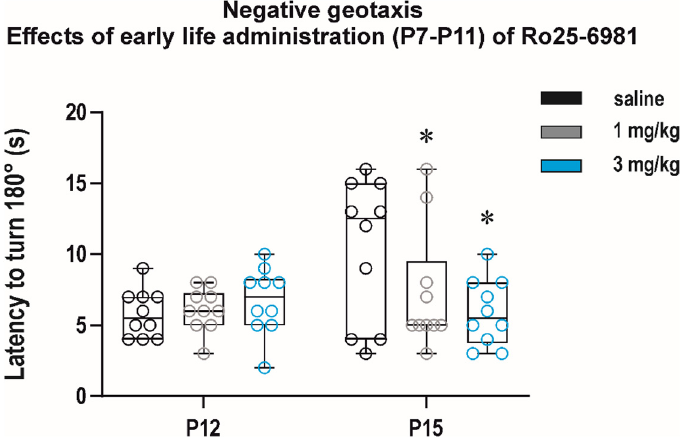
Figure 9. Effects of early life exposure to Ro25-6981 on performance in the negative geotaxis test. Ro25-6981 in two doses, 1 and 3 mg/kg, was administered intraperitoneally for five consecutive days, starting at P7 till P11. Each group consisted of 10 animals, and animals were tested after treatment cessation at P12 and P15 ( x axis). In the 2nd test at P15, animals exposed to Ro25-6981 in both doses managed to turn 180° in a significantly shorter time than the controls ( y axis). All details and symbols as in Figure 4.